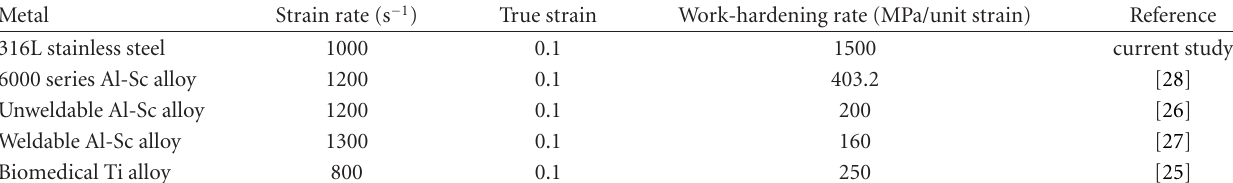
Table 2: Work-hardening rate of various alloys at 25 ◦ C.